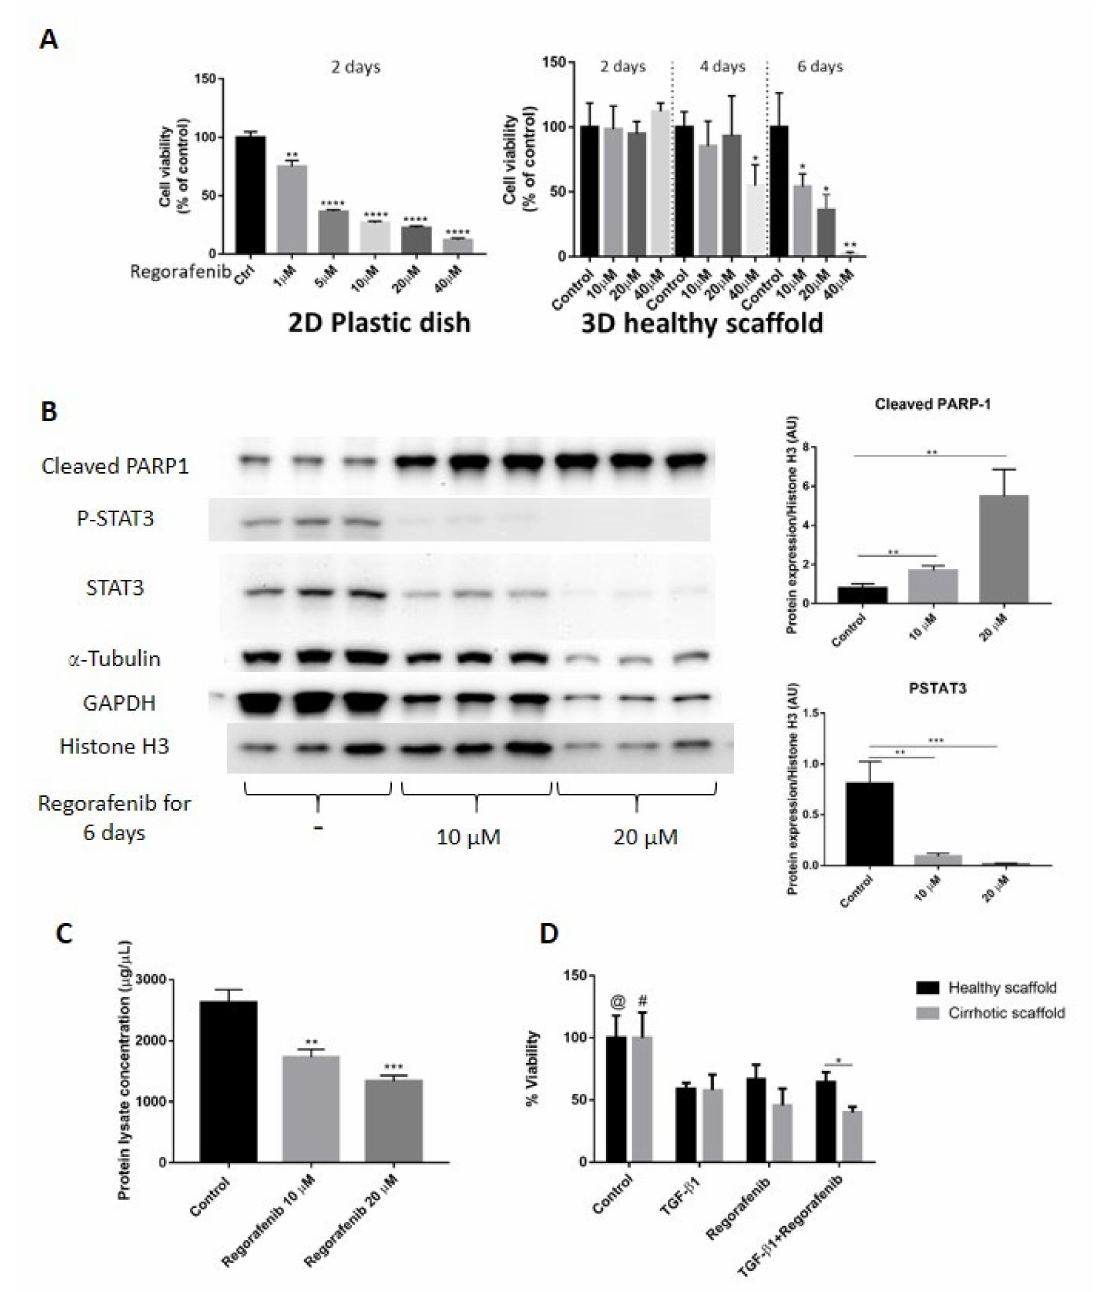
Figure 5. Validation of Regorafenib’s anti-cancer effect on LX2 and HepG2 cell co-culture model in 3D healthy and cirrhotic human liver scaffolds. ( A ) Viability response of LX2/HepG2 cells co-cultured in 2D plastic dish and 3D healthy ECM liver scaffold to Regorafenib. Cells were exposed with a dose escalation and time escalation of Regorafenib (0, 1, 5, 10, 20, and 40 µ M). ( B ) Western blot and densitometry analysis of cleaved PARP-1, P-STAT3, and STAT3 expression in co-culture model in 3D healthy scaffolds treated with Regorafenib (0, 10, and 20 µ M) for 6 days. The α -Tubulin and GAPDH were used as housekeeping proteins. ( n = 4 scaffolds per condition * p ≤ 0.05, ** p ≤ 0.01, *** p ≤ 0.001, and **** p ≤ 0.0001). ( C ) Total protein lysate concentration of LX2/HepG2 cells seeded in 3D healthy control and treated with regorafenib 10 and 20 µ M. ( D ) Viability response of LX2/HepG2 cells grown in 3D healthy and cirrhotic liver scaffolds to TGF- β 1 5 ng/mL, Regorafenib 16.6 µ M, and combination therapy for 6 days. @ indicates p ≤ 0.05 for control vs. other conditions in healthy scaffolds. # indicates p ≤ 0.05 for control vs. other conditions in cirrhotic scaffolds. (Figure S1: Whole blot showing all the bands with all molecular weight markers on the